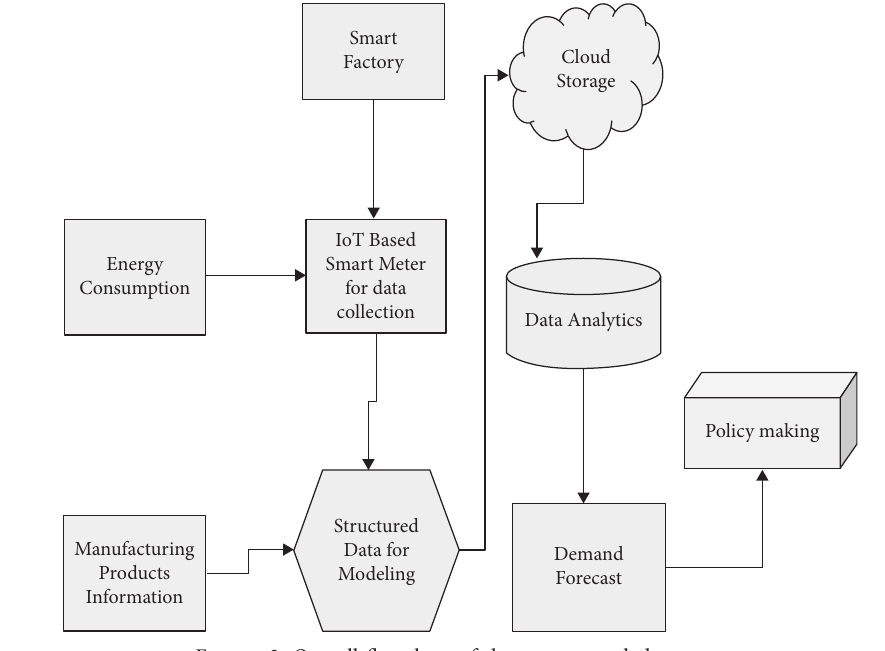
Figure 3: Overall flowchart of the recommended system.